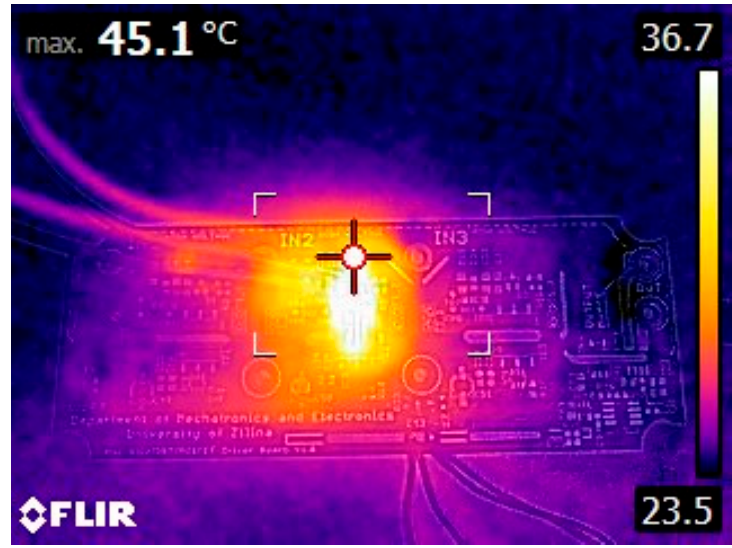
Figure 12. The temperature of the isolated power supply at the load of 2 W .